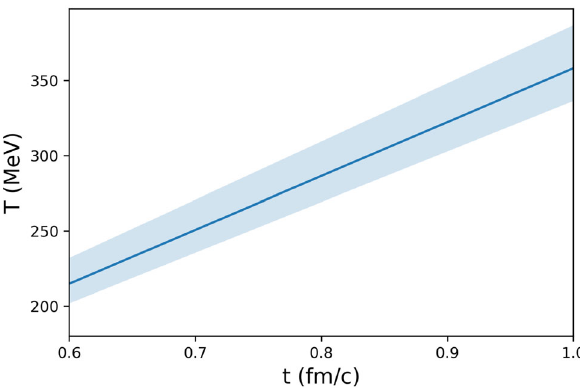
Fig. 5 Averagetemperatureasafunctionoftime.Theuncertaintyband represents the theoretical uncertainty in the number of degrees of free- dom 25 < ν( T ) < 38